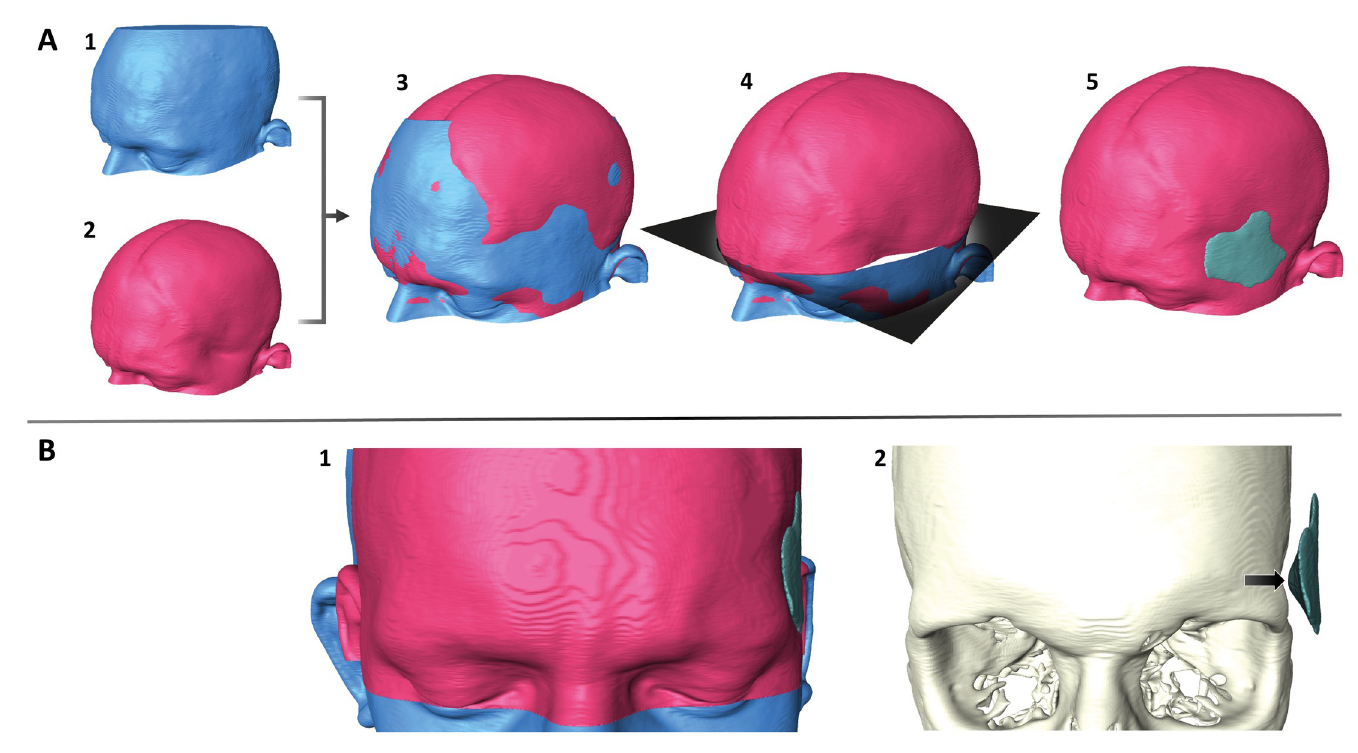
Fig 1. Illustration of the workflow of the 3D analysis at the example of one representative case. A1 pre-CT before craniectomy, A2 late-post-cranioplasty CT (late-CT) with clearly visible hollowing of the left temple, A3 fusion of both datasets, A4 resulting defect volume after subtraction of both datasets visualized as a cross section, A5 protocol-optimized defect volume visualized as 3D surface object. B1 front view of pre-CT and late-CT fused on each other with reconstructed defect volume on the left temple, B2 front view of the defect volume in relation to the bone, arrow: Center of the defect volume.